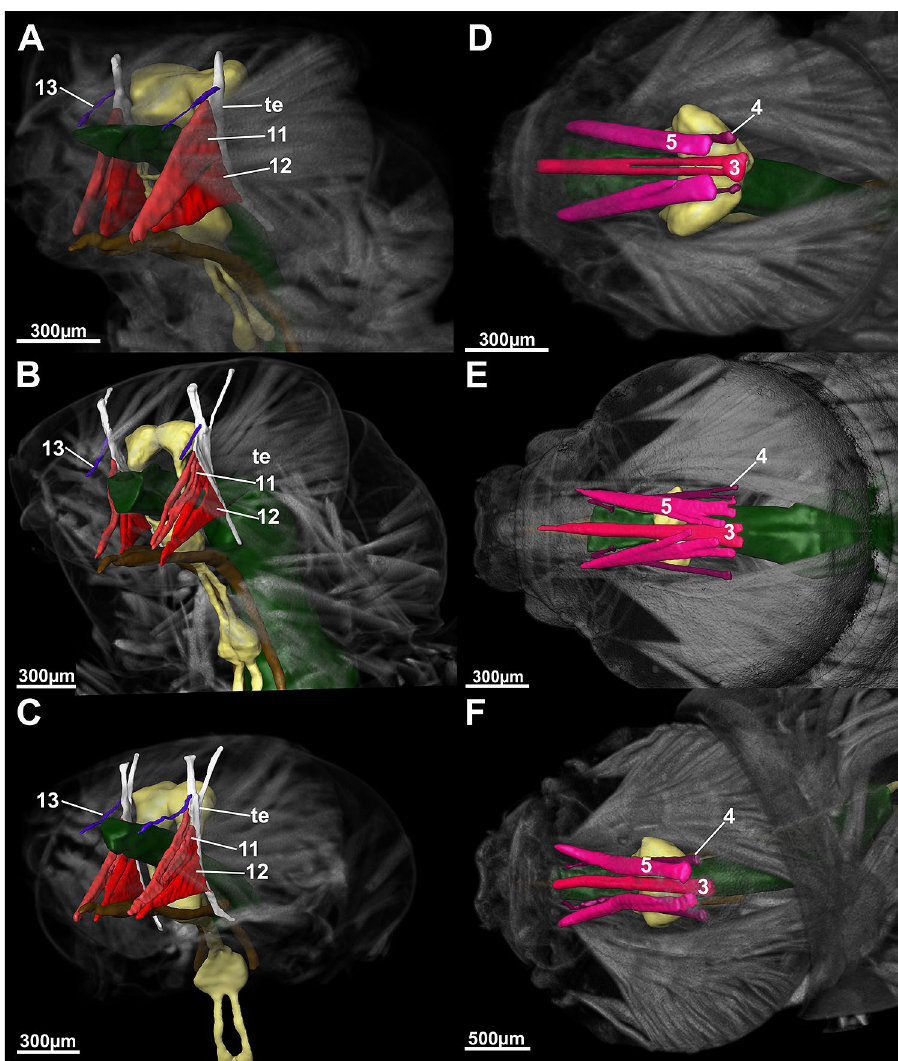
Figure 5. Comparison of the left ventro-lateral ( A – C ) and frontal view ( D – F ) of 5th instar larvae of Drusus discolor ( A , D ), D. bosnicus ( B , E ) and D. franzi ( C , F ) based on µCT data. Abbreviations: 3 = Musculus fronto- labralis, 4 = M. fronto-pharyngalis, 5 = M. fronto-epipharyngalis, 11 = M. tentorio-stipitalis, 12 = M. tentorio- cardinalis, 13 = M. tentorio-mandibularis, te = tentorium. The figure was built using the visualization